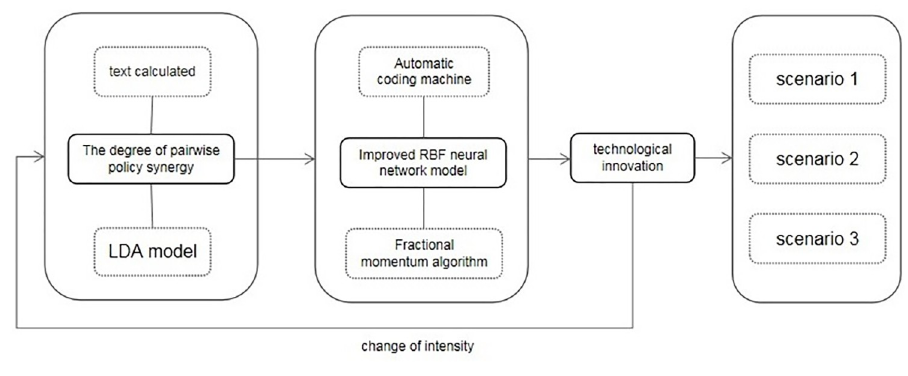
Fig 1. Research process.